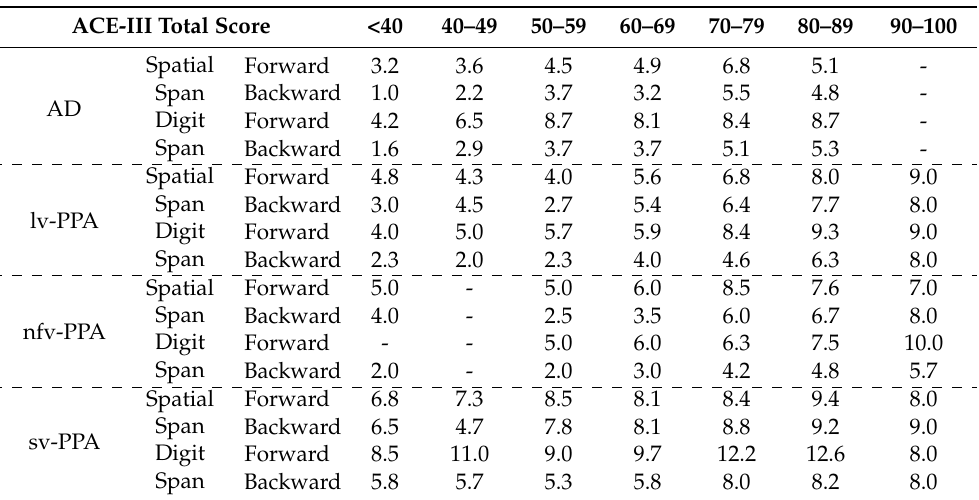
Table 4. Means of Spatial and Digit Span performances stratified by ACE-III Total performance. Sample PPA population was taken from Foxe, Irish